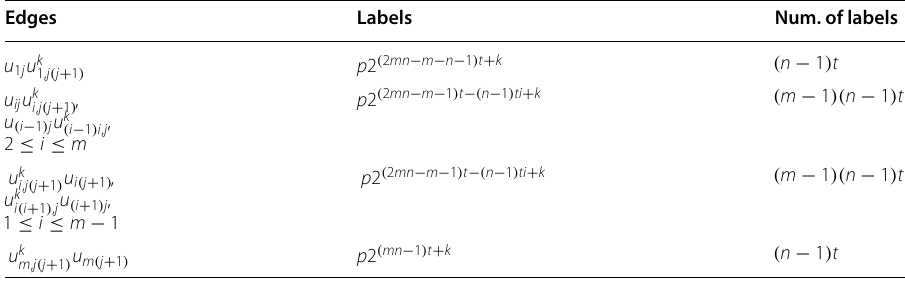
Table 1 Zumkeller numbers used to label the edges of SSD ( P m × P n ) Edges Labels Num. of labels u 1 j u k 1, j ( j + 1